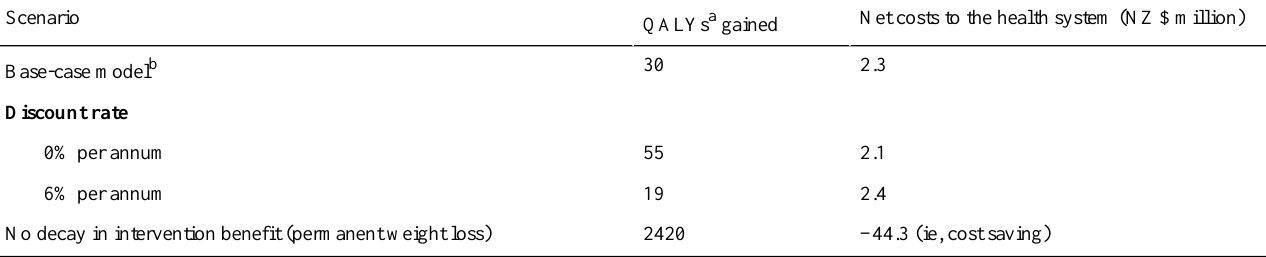
Table 5. Scenario analyses about health gain in quality-adjusted life-years and health system costs for the promotion of smartphone apps for weight loss compared with business as usual (expected value analysis; no